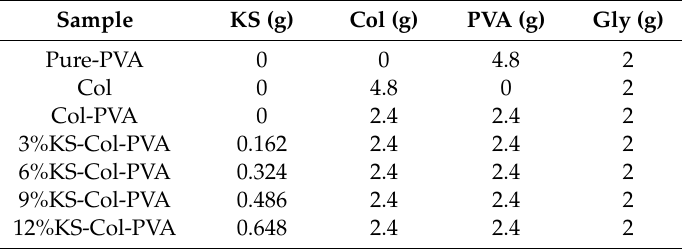
Table 3. Composition of di ff erent composite